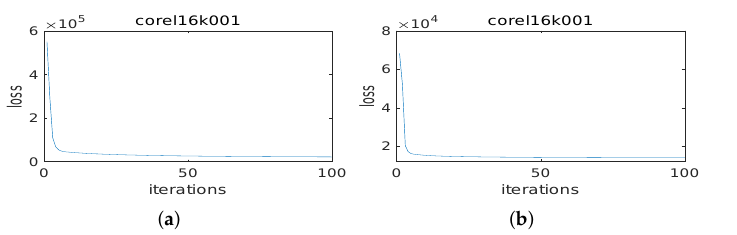
Figure 3. Convergence analysis of MLLCE and NL-MLLCE over corel16k001 data set. ( a ) Linear MLLCE; ( b ) Nonlinear